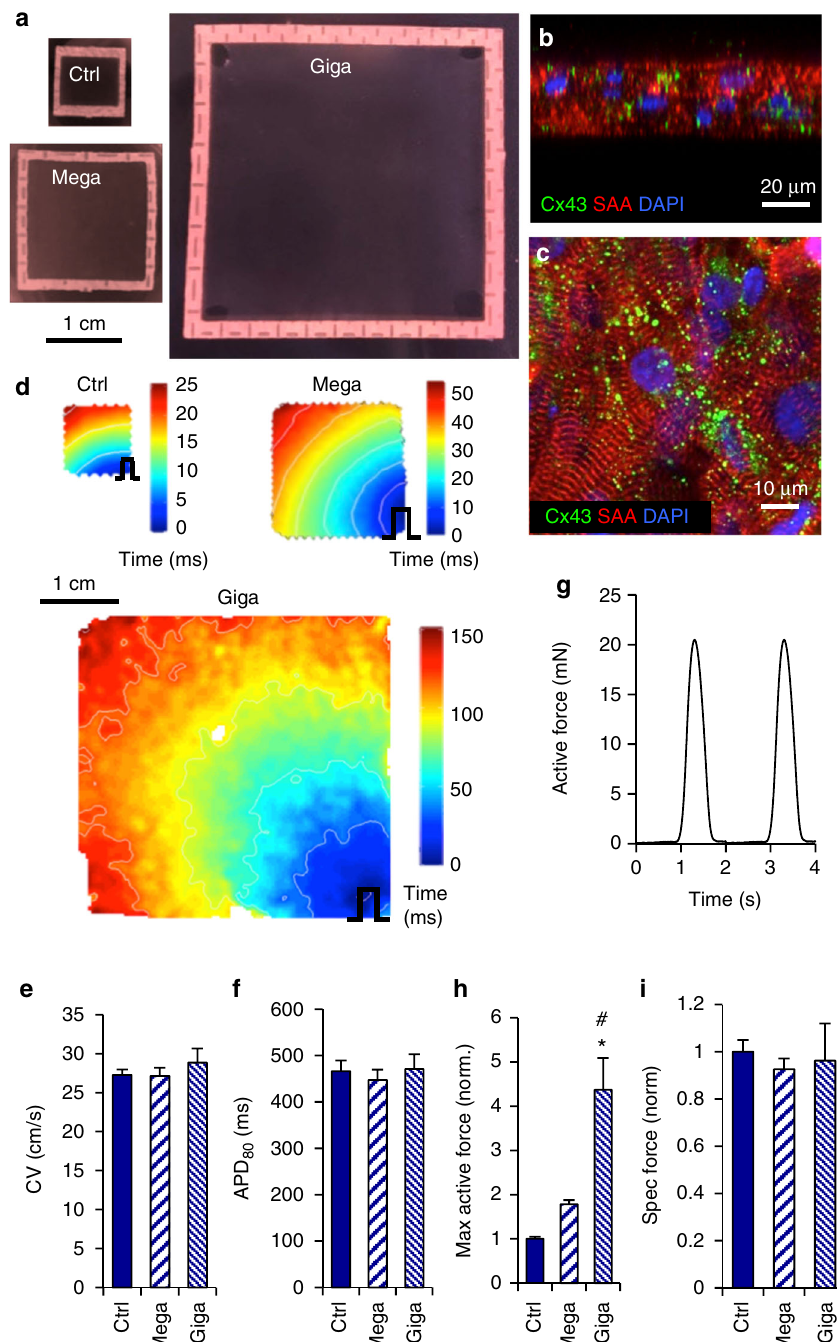
Fig. 5 Scale-up of cardiopatches without loss of function. a Representative images of control (ctrl, 7 × 7 mm), Mega (15 × 15 mm) and Giga (36 × 36 mm) cardiopatches at 3 weeks of culture. Scale bar 1 cm. b , c Representative confocal images of 3-week-old Giga cardiopatches stained for Cx43 and SAA, as seen in confocal cross-sections ( b ) or in the XY plane in the middle of the patch ( c ). Scale bars 20 µ m ( b ), 10 µ m ( c ). d Representative activation maps of ctrl, Mega, and Giga cardiopatches following point stimulation from bottom right corner (pulse sign). Giga patches were imaged by an EMCCD camera. Scale bar 1 cm. e Conduction velocity (CV) in 3-week-old ctrl, Mega and Giga cardiopatches; n = 11/6/7 patches (ctrl/Mega/Giga) from three to four differentiations; p = 0.56, one-way ANOVA. f Action potential duration at 80% repolarization (APD 80 ) in 3-week-old ctrl, Mega and Giga cardiopatches; n = 11/6/5 patches (ctrl/Mega/Giga) from three to four differentiations; p = 0.52, one-way ANOVA. g Representative isometric force trace from spontaneously contracting 3-week-old Giga cardiopatch at 16% stretch. h , i Maximum active forces ( h ) and speci fi c forces ( i ) in 3-week-old ctrl, Mega, and Giga cardiopatches shown relative to Ctrl cardiopatch; n = 10/6/10 patches (ctrl/Mega/Giga) from three to four differentiations; * p < 0.0001 vs. ctrl, # p < 0.01 vs. Mega, post hoc Tukey ’ s tests; ( i ) p = 0.76, one-way ANOVA. Data are presented as mean ±